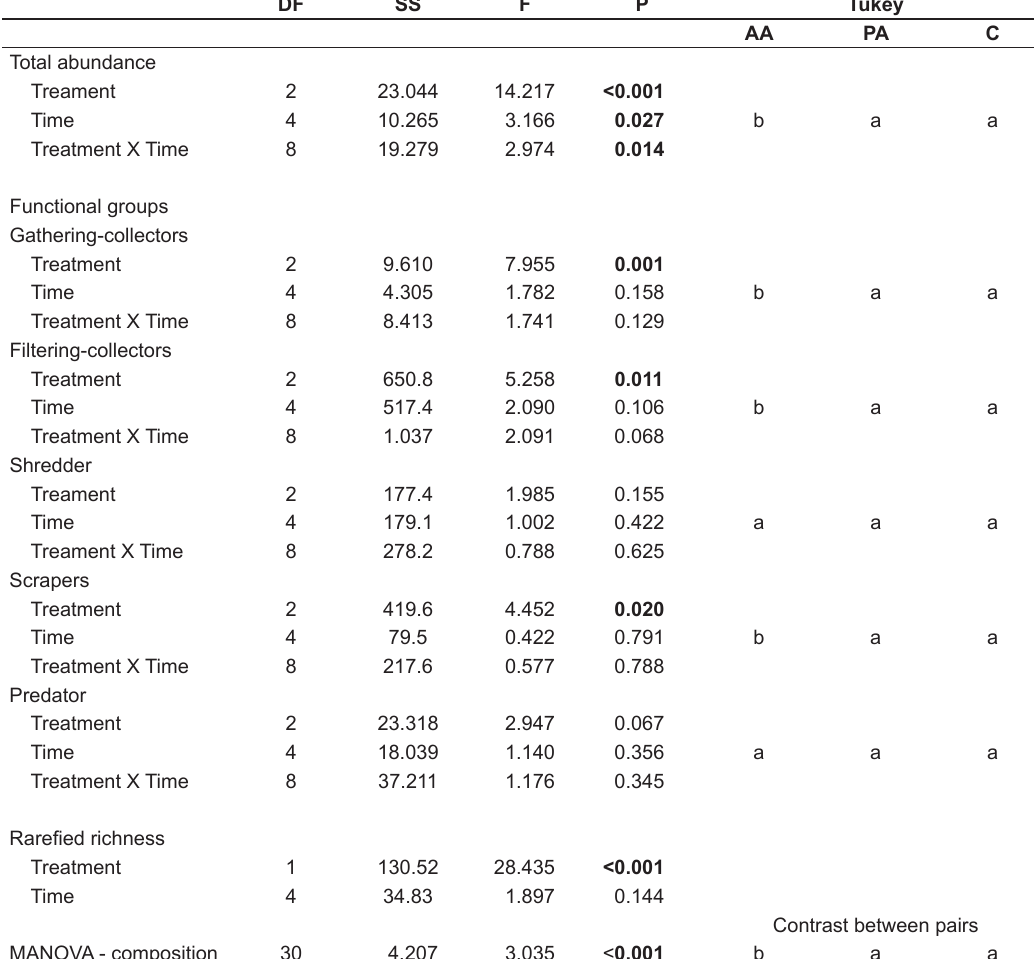
Table 2. Statistical values of the analyses (bifactorial ANOVA, paired t-test and MANOVA) testing the effect of A. longirostri and time exposed in the stream on general abundance, abundance of trophic groups and rarefied richness of aquatic invertebrates. The contrasts were evaluated with a Tukey test by comparing the treatments. Significance results in bold. Different letters denote significant differences (confidence interval of 95%). DF = degrees of freedom; SS = sum of squares; AA = absence of A. longirostri ; PA = presence of A. longirostri ; C =